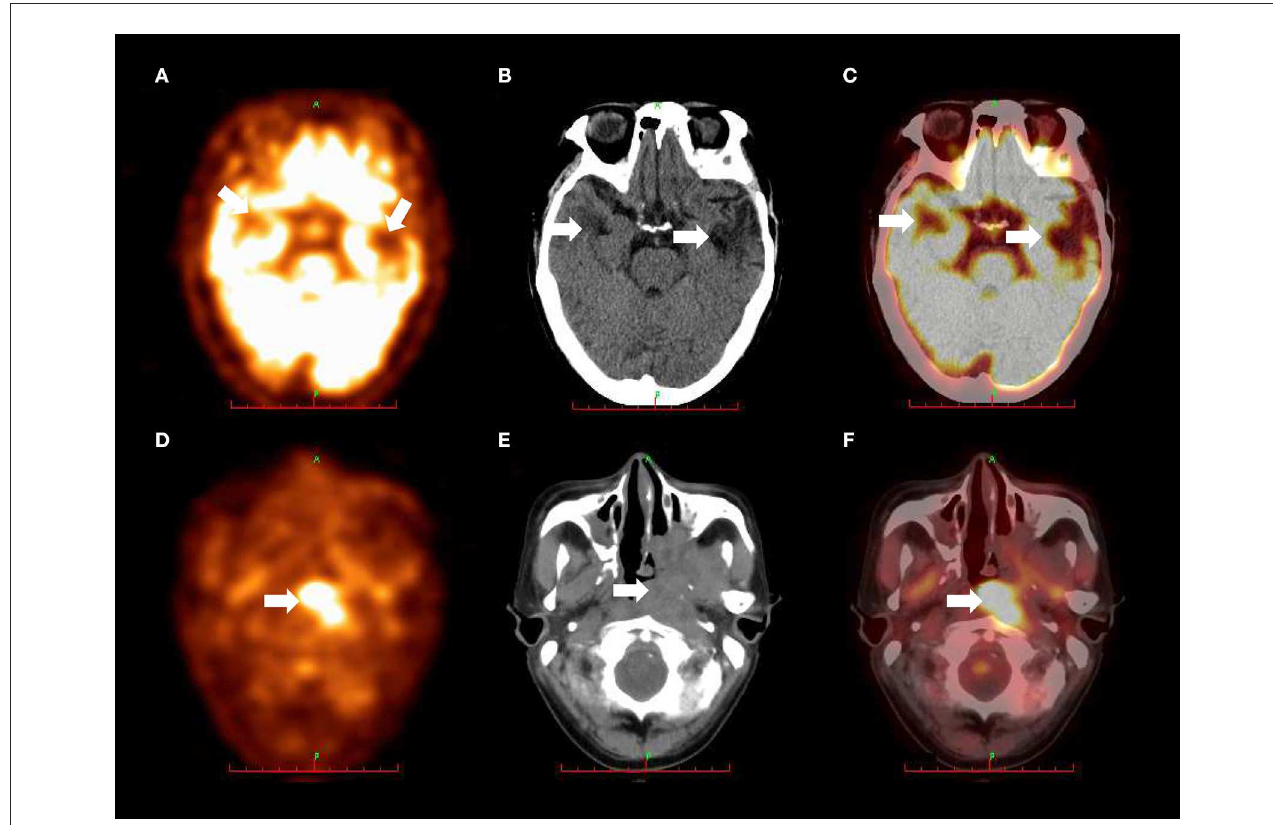
FIGURE2 (A) PET scan revealed decreased fluorodeoxyglucose uptake in the bilateral temporal lobes (arrows). (B) CT scan showed patchy low-density areas in the bilateral temporal lobes (arrows). (C) 18 F-FDG PET/CT fusion imaging demonstrated decreased fluorodeoxyglucose uptake in the bilateral temporal lobes (arrows). These metabolic abnormalities on bilateral temporal lobes were appearance of radiation-induced brain necrosis and were not correlated with E. miricola encephalitis. (D) PET scan revealed increased fluorodeoxyglucose uptake in the left nasopharyngeal lateral wall (arrow). (E) CT scan showed soft tissue mass with unclear boundary in the left nasopharyngeal lateral wall (arrow). (F) 18 F-FDG PET/CT fusion imaging demonstrated increased fluorodeoxyglucose uptake in the left nasopharyngeal lateral wall (arrow). 18 F-FDG PET/CT, and 18 F-Fluoro-2-deoxyglucose positron emission tomography/computed